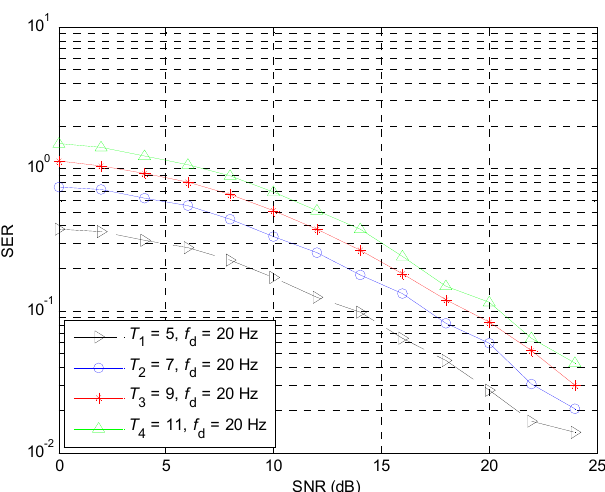
Figure 6. SER performance of the 16 QAM-modulated CP-OFDM system over Brazil B with a Doppler spread of 20 Hz.